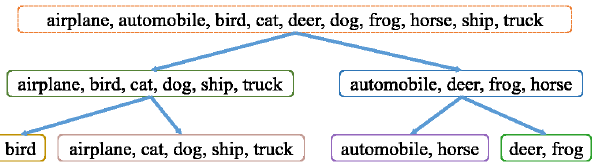
Figure 4. Result of the hierarchical structure label generation on the CIFAR-10